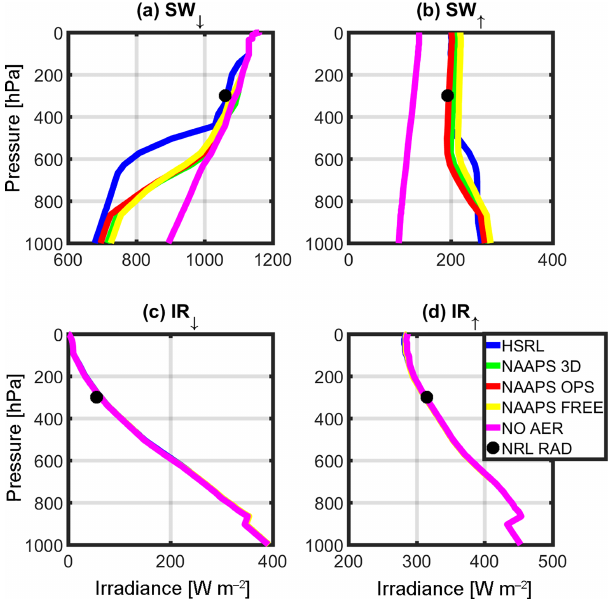
Figure 4. Same as Fig. 3, but with MSPI BB (BRF = 0.096711). Figure 5. Same as Fig. 3, but with MAIAC 555µm (BRF =